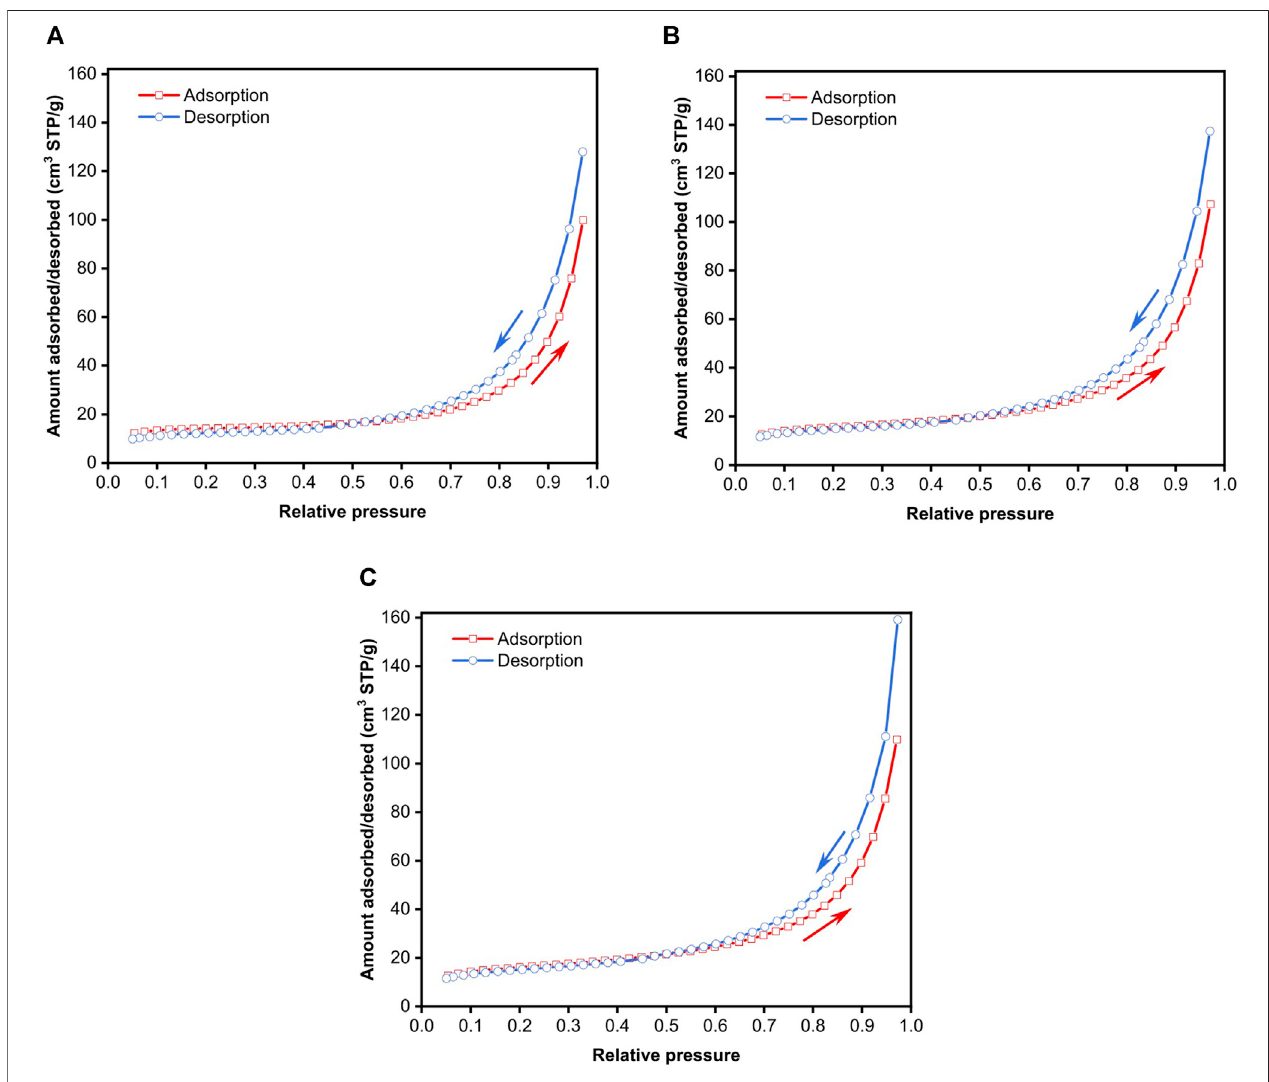
FIGURE 1 | N 2 adsorption-desorption isotherms of freeze-dried BC based on the (A) fi rst adsorption-desorption run immediately after degassing, (B) second adsorption-desorption immediately after the fi rst run and (C) third adsorption-desorption run immediately after the second run.